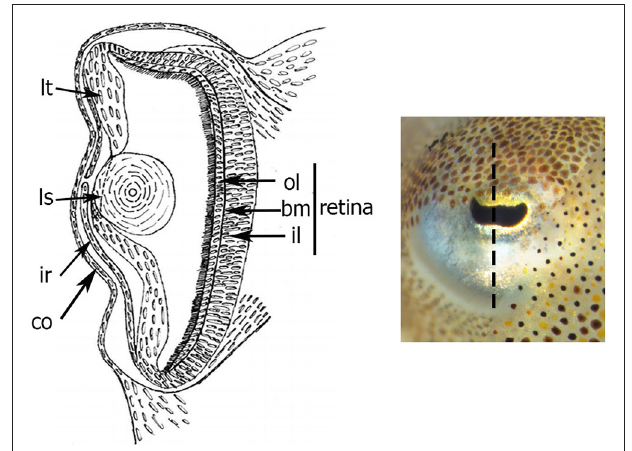
FIGURE 1 | Schema of transversal section of the eye of S. officinalis at stage 30. Black dotted-line shows the level and the orientation of the section. bm: basement membrane; co: cornea; il: inner layer; ir: iris; ls: lens; lt: lentigenic tissue; ol: outer